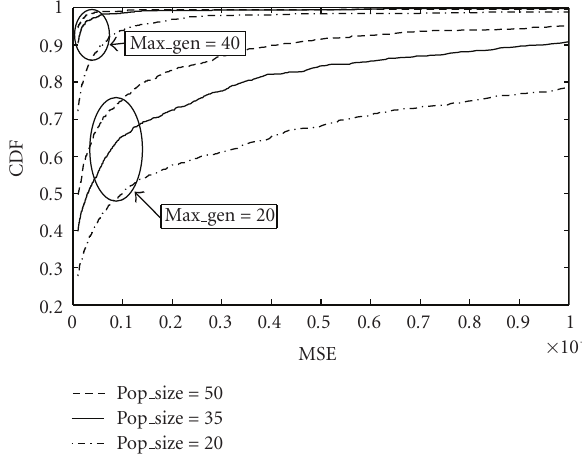
Figure 11: CDF (Cumulative Distribution Functions) of the squared error with various population dimensions in LSC weights